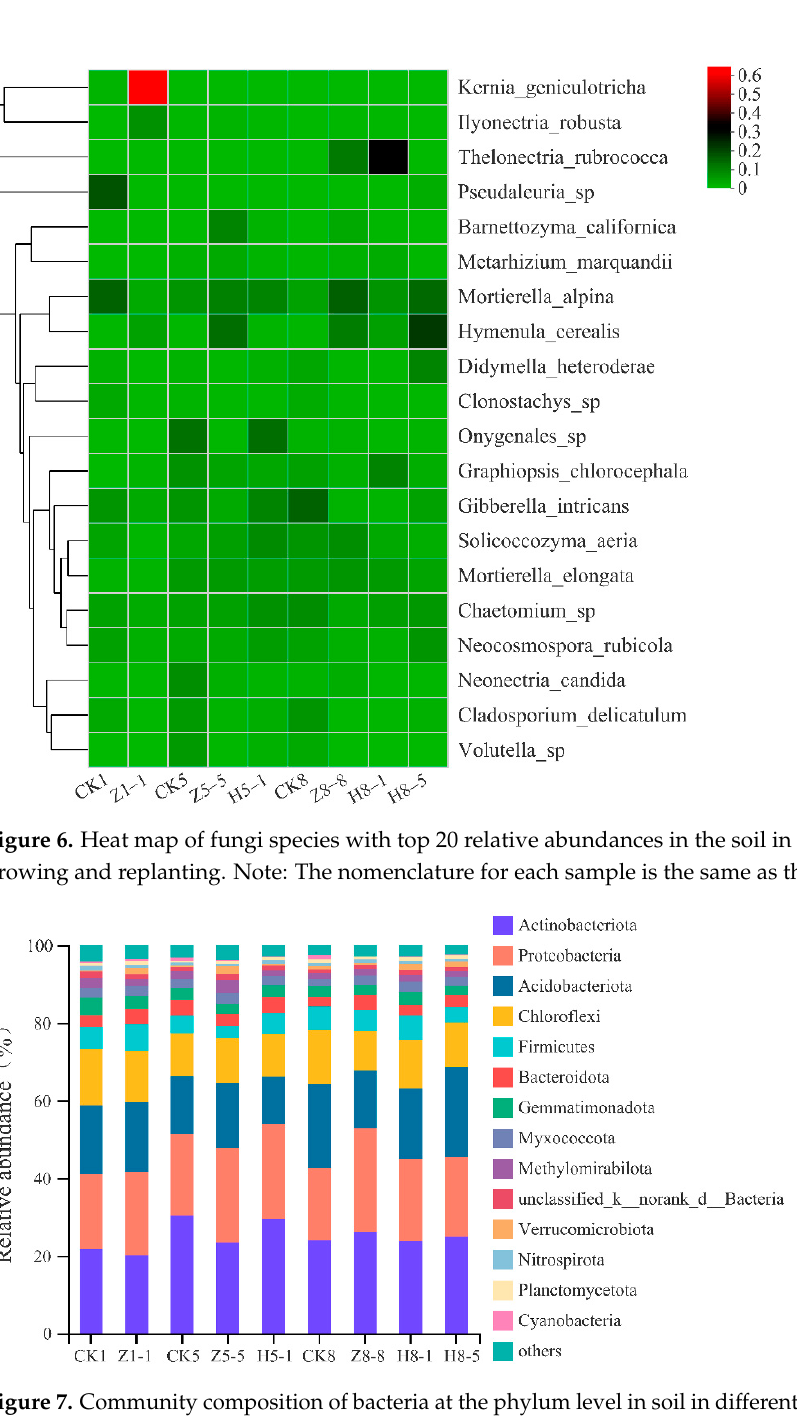
Figure 7. Community composition of bacteria at the phylum level in soil in different years of grow- ing and replanting. Note: The nomenclature of each sample is the same as that in Table 2.